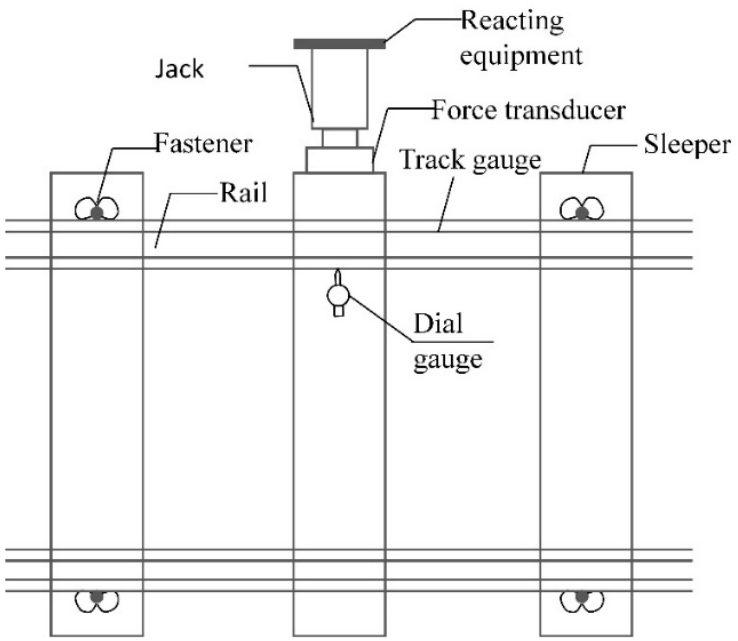
Figure 3. Test schematic diagram of lateral ballast resistance.